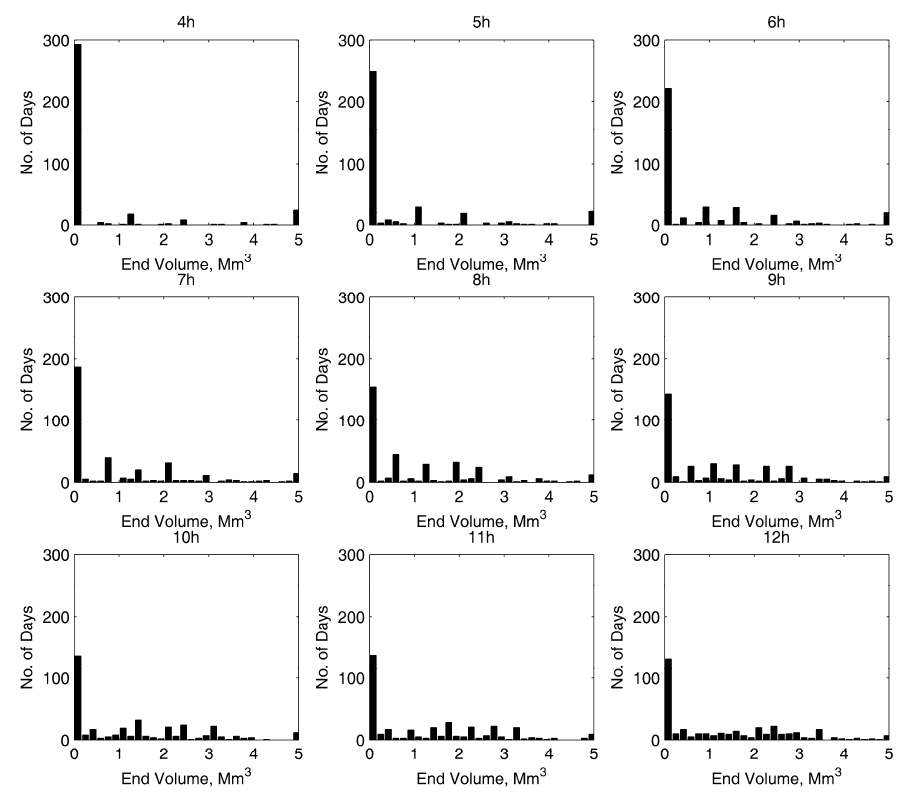
Figure 10. Histogram of the end of day volumes for each PSHP participating in the DM.